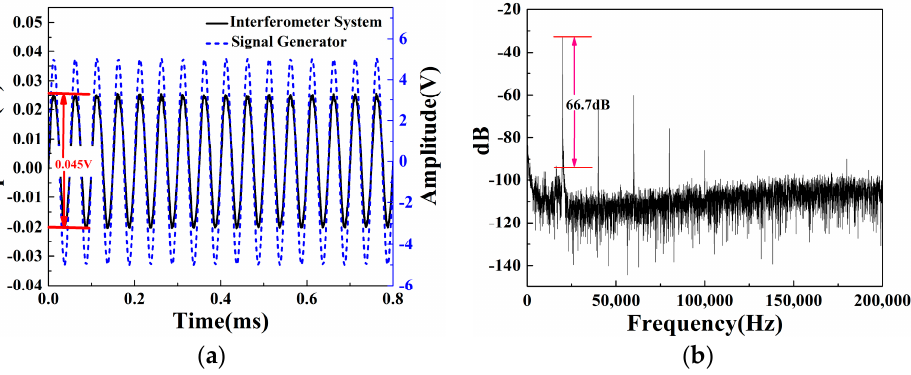
Figure 4. ( a ) The same acoustic emission detected with the interferometer system and the signal generator; ( b ) The detected acoustic frequency of the interferometer system.